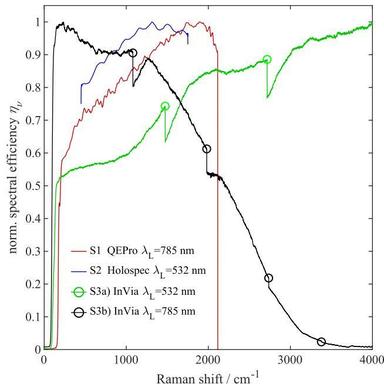
Spectral efficiencies of the setups used in this work, the respective maximum was normalized to 1; determined via broadband calibration lamps with known spectral emission profiles. The circles mark the positions where the spectra were joined in the case of S3.